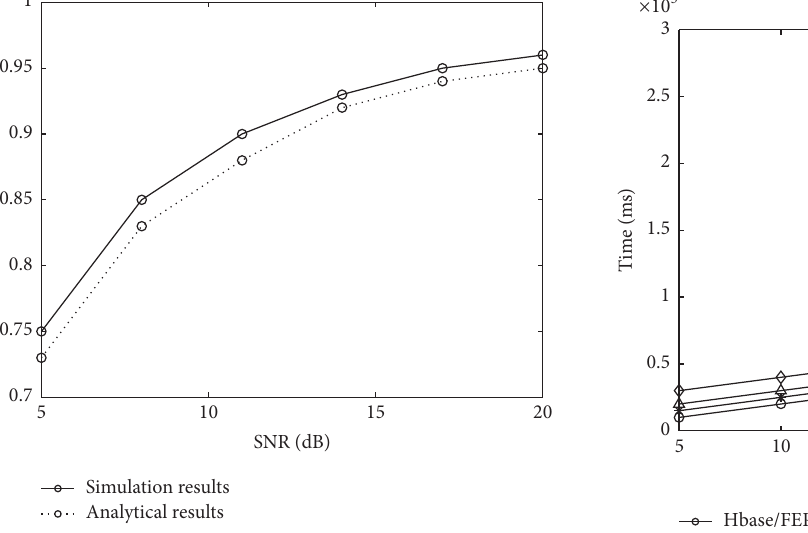
Figure 7: Average system accuracy versus SNR.